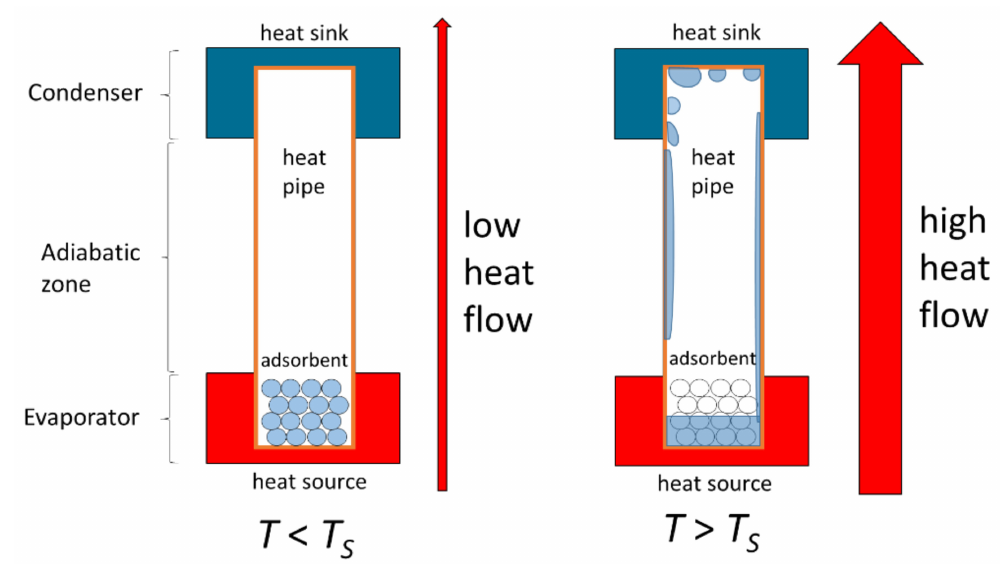
Figure 1. Basic concept of thermal heat switch. Below the activation temperature or switching temperature T S , the working fluid is in an adsorbed state and the heat pipe exhibits a high thermal resistance (“off-state”). Above T S , the working fluid is released by desorption. Latent heat transport is enabled, significantly lowering the thermal resistance of the heat pipe (“on-state”) [9]. Compared to the state of the art as given in reference [9], current work contains